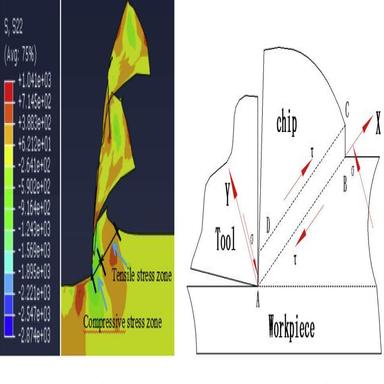
Schematic diagram of the formation of adiabatic shear bands.